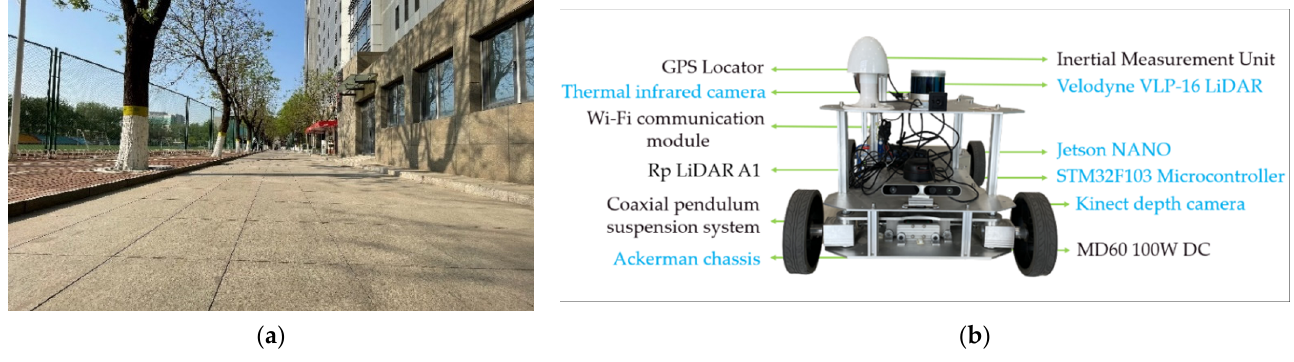
Figure 11. Experimental platform based on automated patrol vehicle. ( a ) Experimental scenario. ( b ) Automated patrol vehicle.